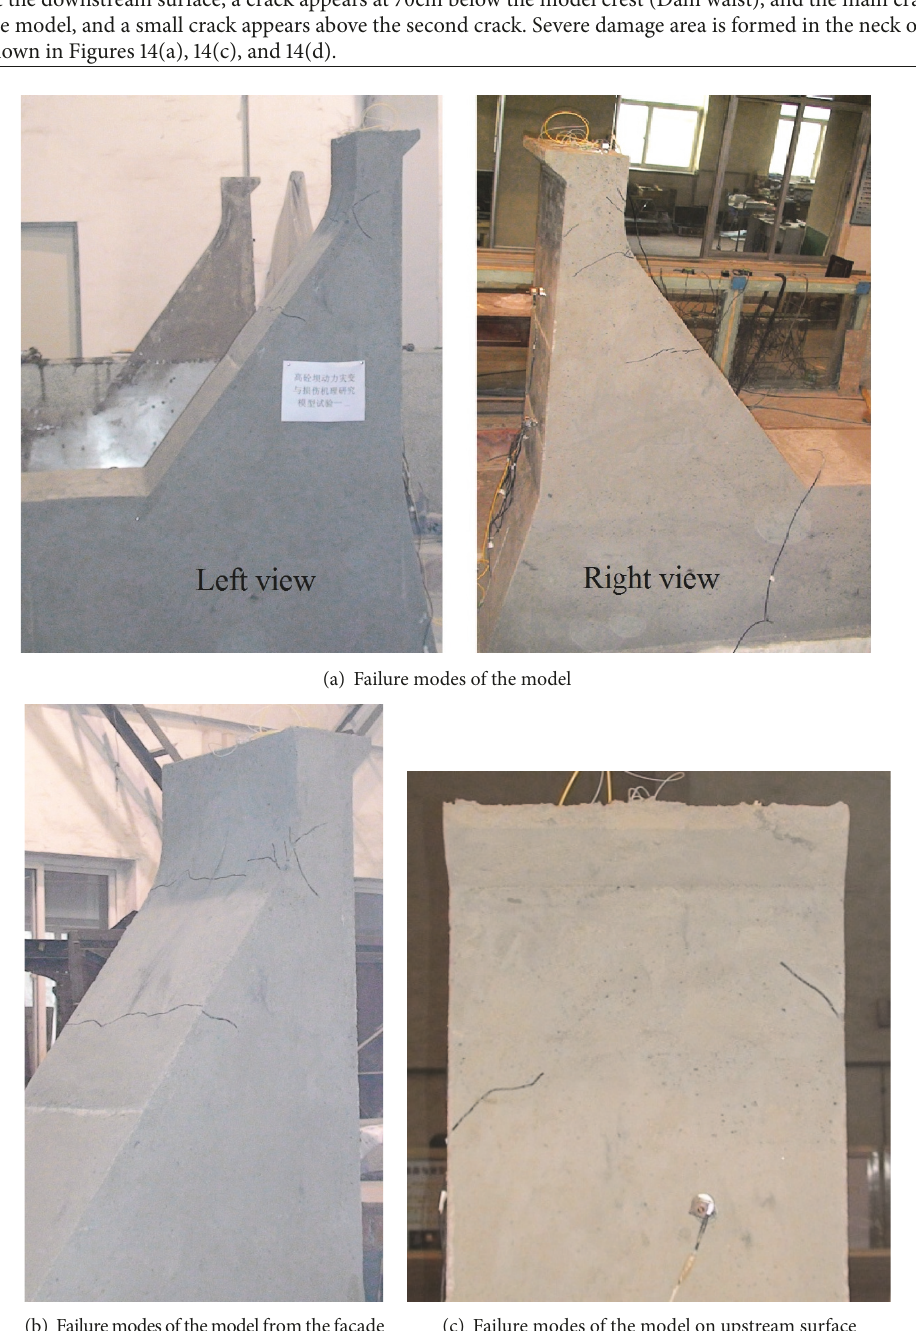
Figure 14: Illustration of the damaged zones of the